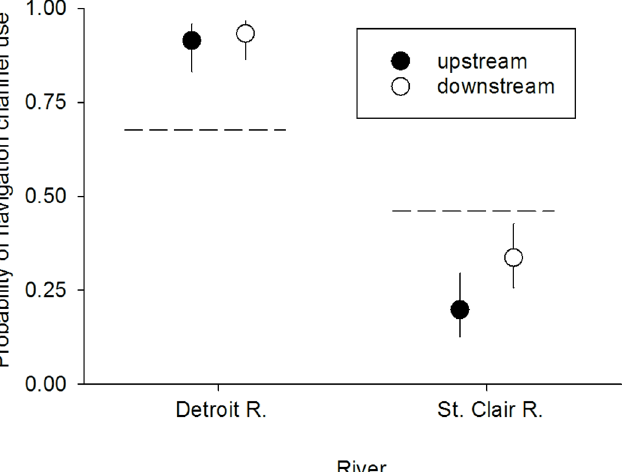
Fig 6. Probability (mean ± 95% confidence interval) of navigation channel use by acoustic-tagged Lake Sturgeon by river (Detroit vs. St. Clair) and direction of movement (upstream vs. downstream). Expected probabilities of navigationchanneluse under the null model are shown as dashedhorizontallines.